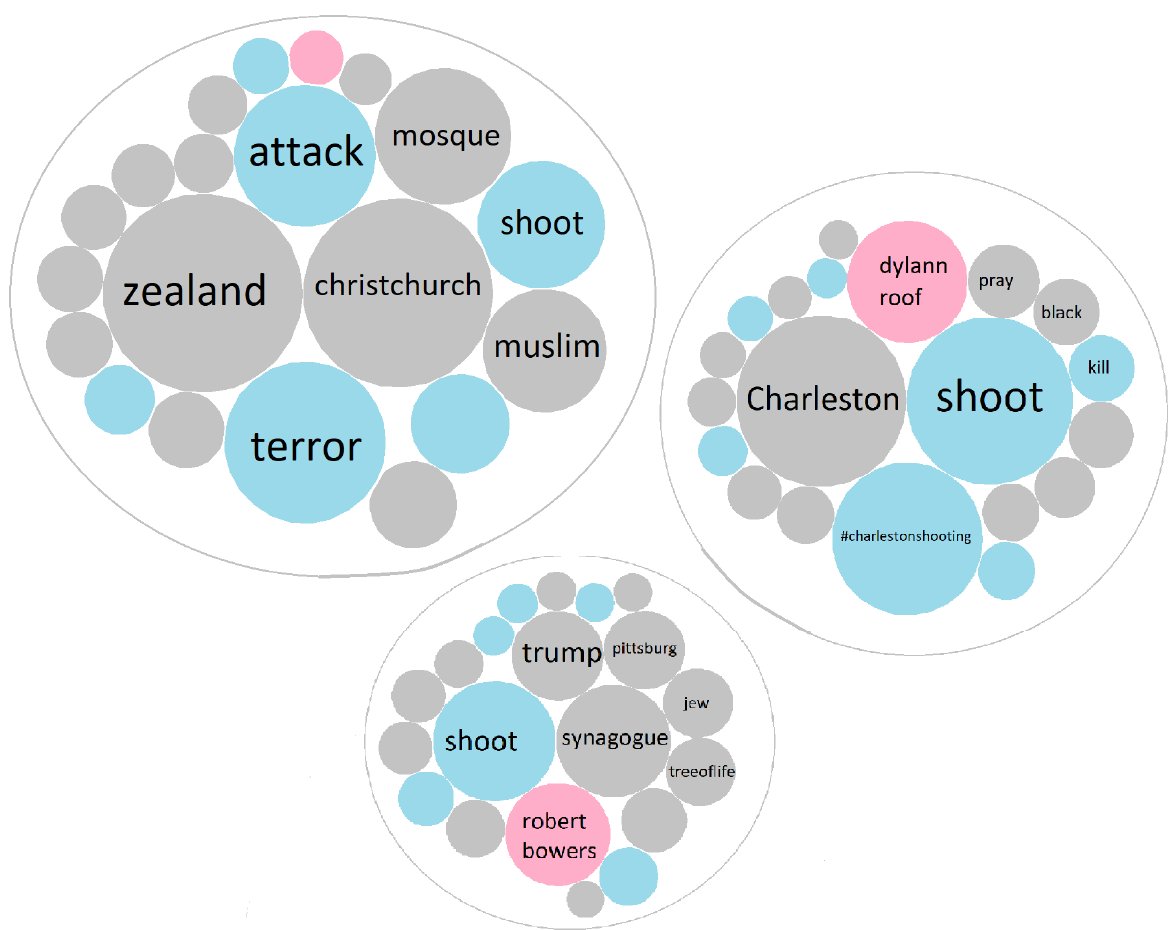
Figure 5. Word bubble for the three datasets word frequency (Mauri et al.